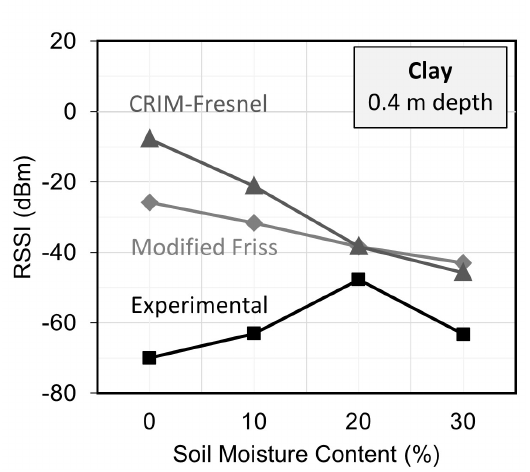
Figure 7. LoRa signal strength in clay with different moisture content at depth of